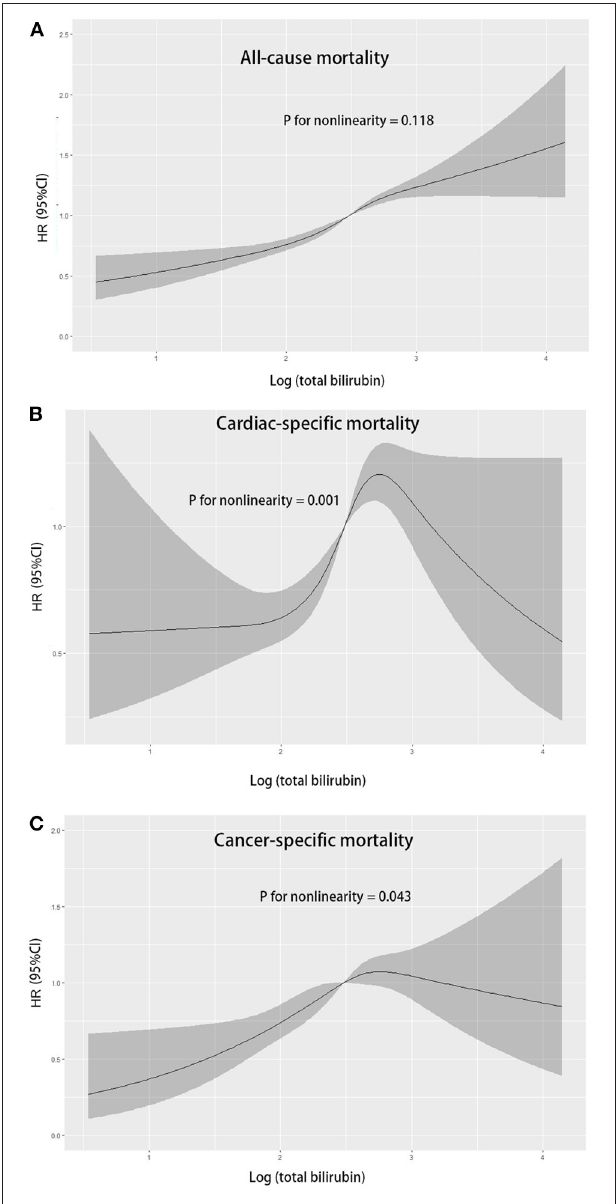
FIGURE 2 | Multivariable adjusted hazard ratios for all-cause mortality (A) , cardiovascular mortality (B) , and cancer mortality (C) according to levels of total bilirubin levels on a continuous scale (log-transformed) in overall population. Solid blue lines are multivariable adjusted hazard ratios, with shadow lines showing 95% confidence intervals derived from restricted cubic spline regressions.